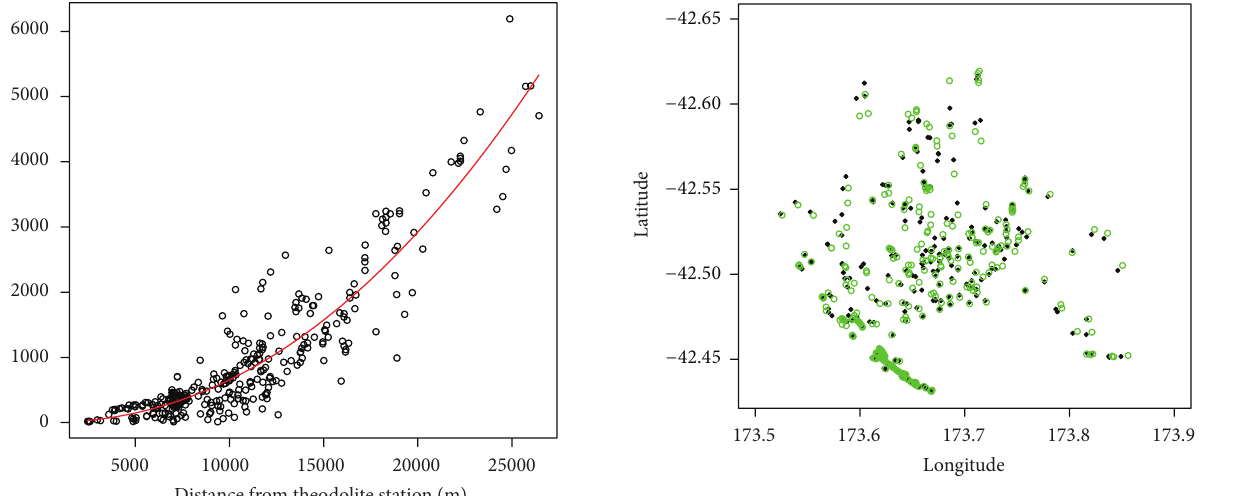
Figure 6: Comparison of the corrected positions of the research vessel over all years recorded by theodolite (green dots) and by onboard GPS (black dots).